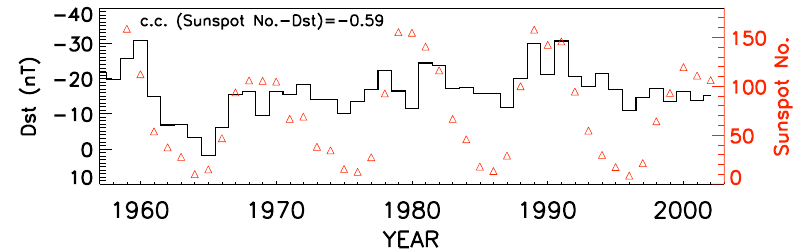
Fig. 2. Yearly averages of sunspot number ( 4 ) and geomagnetic activity index, D st (solid line), during 1957–2002.